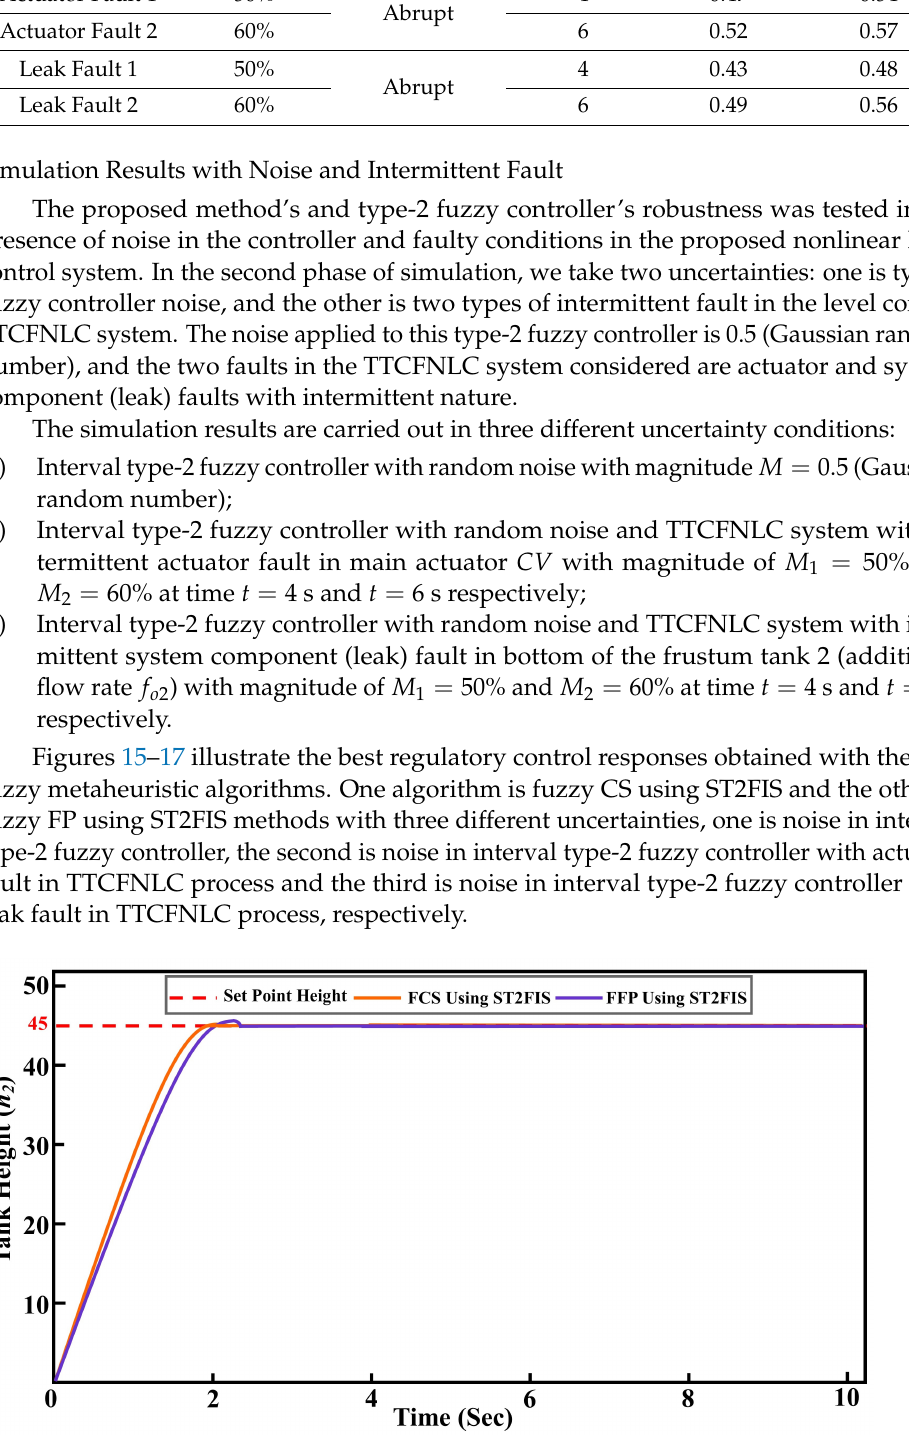
Figure 15. Comparative results of TTCFNLC process subject to random noise in fuzzy controller using fuzzy CS and FP